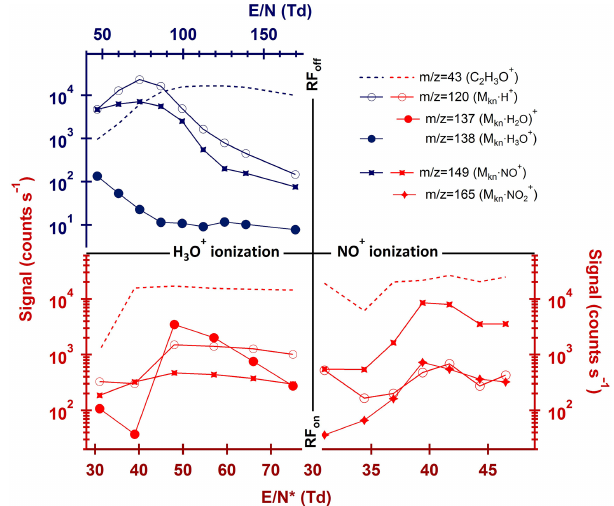
Figure 6. The E/N ratio influence over the KnC3 identification for several representative signals in both ionization modes (H 3 O + , left; NO + , right) as recorded in absence (up)/presence (down) of a RF funnel. The common signal at m/z = 43 is equally plotted as a fragmentation mark (right